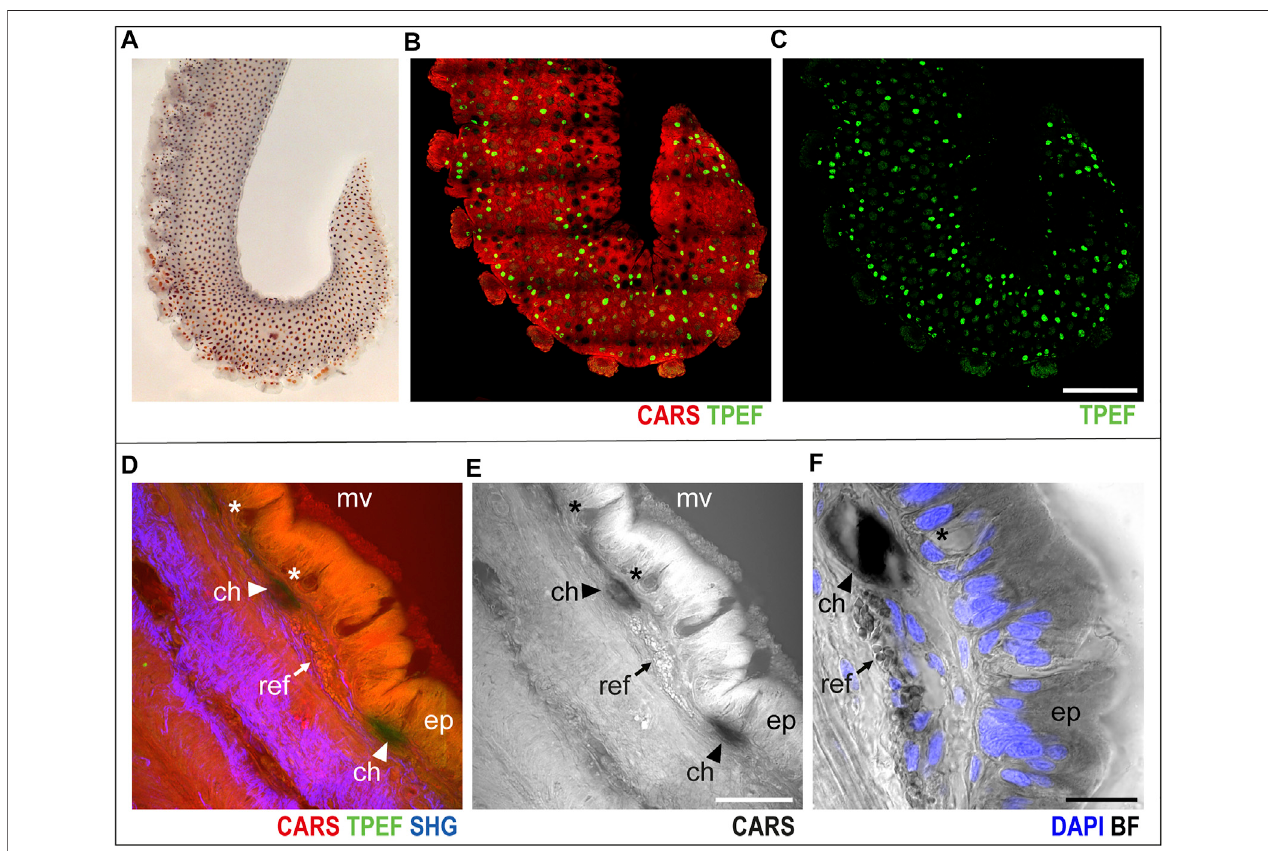
FIGURE 1 | Arm skin structure and re fl ective elements. An isolated ex vivo arm tip imaged before fi xation (A) with visible chromatophores. The same sample was imaged in whole mount through multiphoton microscopy. (B) Entire arm structure is shown in CARS (red), while chromatophores appear in TPEF (green spots in B,C ). (D,E) Imagingofthin sections(30 μ m, sagittal plane)highlightedthepresence ofmicrovilli(mv)coveringtheepidermis (ep);mucous cells(asterisks) arefounddistributed in the epidermis. Re fl ective elements (arrows) are identi fi ed as round granules in the dermal layer close to chromatophores (arrowheads). (F) Bright- fi eld (BF) imaging of the same section counterstained with DAPI showed chromatophores (arrowhead) and re fl ective elements (arrow) underneath the epidermal layer, where mucous cells (asterisk) are identi fi ed based on morpholgy and position. Scale bars: 150 µm in (B,C) , 50 µm in (D,E) , and 20 µm in (F) . Abbreviations: ch, chromatophores; ep, epidermis; mv, microvilli; ref, re fl ective elements.